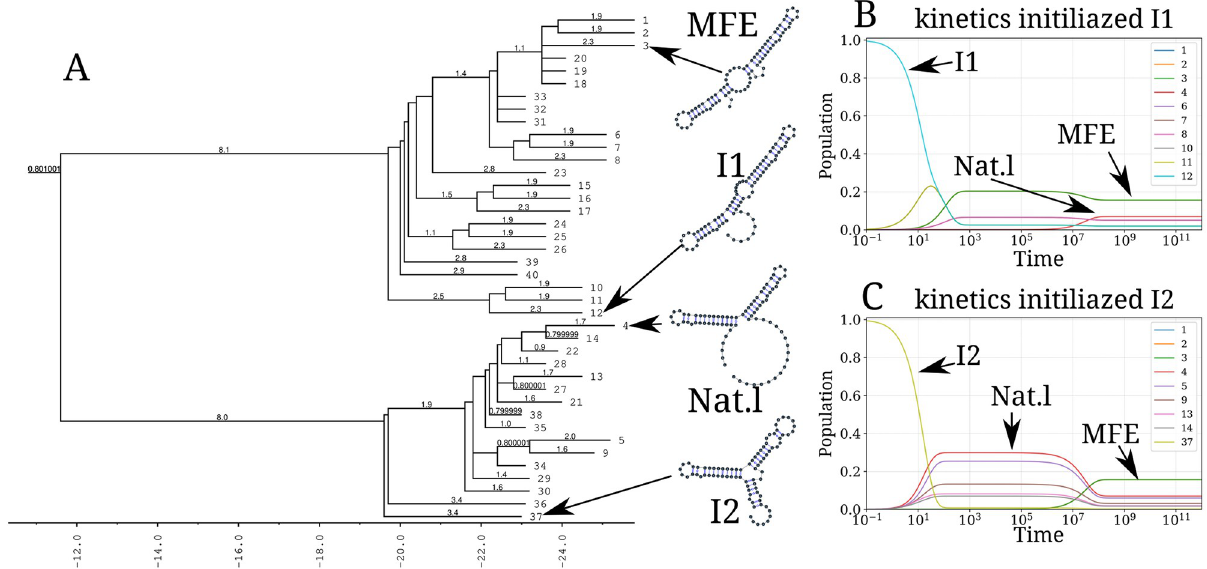
Fig 8. Folding kinetics of CFSE using Treekin . A) Barrier tree of the CFSE. From a set of 1.5 × 10 6 sub-optimal structures, 40 local minima were found, connected through saddle points. The tree shows two alternative structures separated by a high barrier with the global minimum (MFE structure) on the right side. (B) Folding kinetics with initial population I 1 . Starting from an initial population of I 1 , as the initial frequency decreases, the others increase, and gradually the MFE structure is the only one populated. (C) Folding kinetics with initial population I 2 . When starting with a population of I 2 , the native structure (labelled Nat.1 ) is observable, and gets kinetically trapped for a long time due to the high energy barrier separating it from the MFE structure.